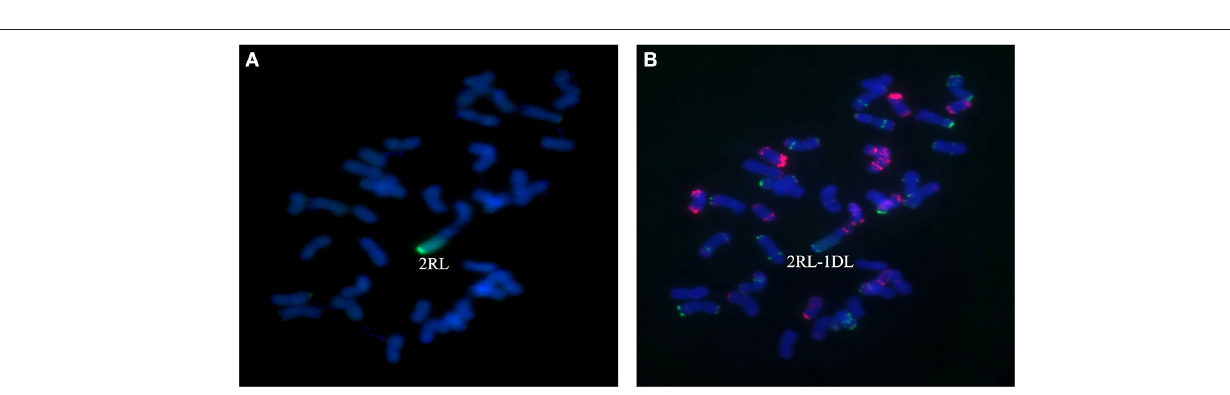
to wheat powdery mildew and leaf rust diseases as well as triticale diseases. However, the resistance has not been investigated and resistance to wheat powdery mildew and leaf rust derived from